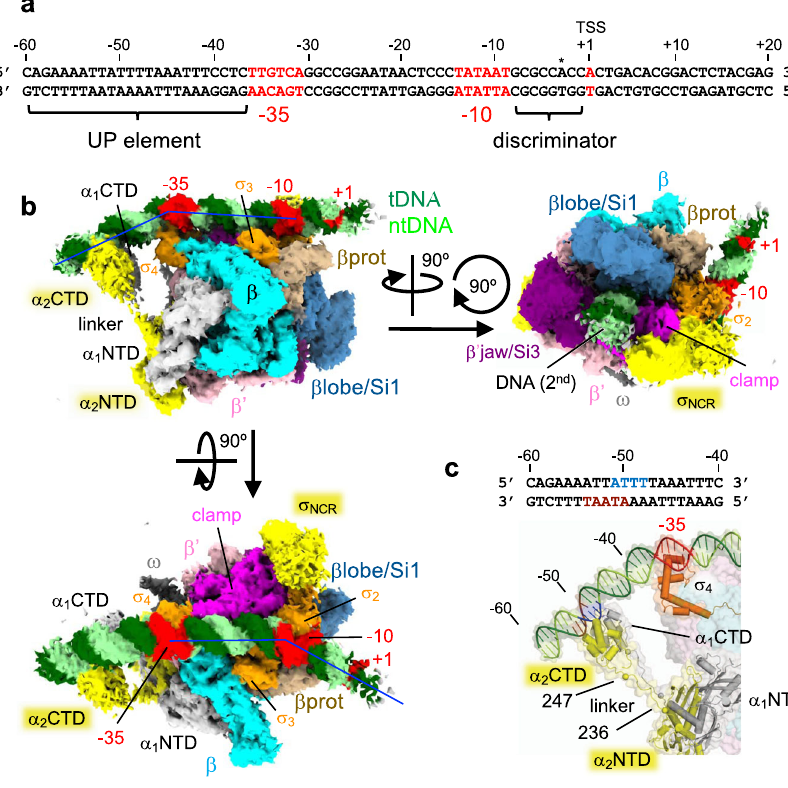
Fig. 1 Cryo-EM structure of the RNAP- rrnB P1 closed complex (RPc). a The sequence of the E. coli rrnB P1 promoter DNA used for cryo-EM. The UP element, − 35 element, − 10 element, transcription start site (TSS, + 1) and discriminator sequence are indicated. Alternative TSS from the nonscrunched open complex is indicated by an asterisk. b Orthogonal views of the RPc cryo-EM density map. Subunits and domains of RNAP and DNA are colored and labeled ( β prot, β protrusion; tDNA, template DNA; ntDNA, nontemplate DNA). The density of downstream DNA beyond the + 4 position is not traceable. Blue lines denote the direction of the DNA axis, with kinks at ~ − 37 and − 13. The second DNA at the RNAP cleft is indicated (DNA (2nd)). c A magni fi ed view showing the α CTDs and UP element interaction. The domains of α subunits, σ 4 , and DNA are depicted as ribbon models with a partially transparent surface. At the top, the sequence of the UP element is shown. The ntDNA ( − 51 to − 48) and tDNA ( − 54 to − 50) sequences binding α 1 CTD and α 2 CTD are highlighted in blue and brown,